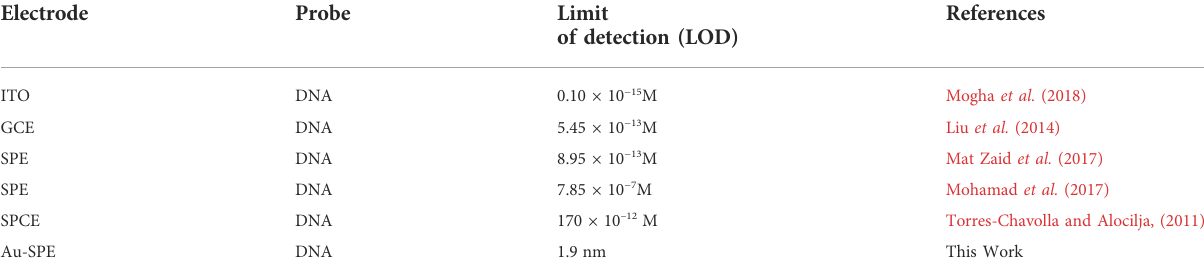
TABLE 1 Comparison of the present work and other reported electrochemical sensing technique for the detection of M. tuberculosis